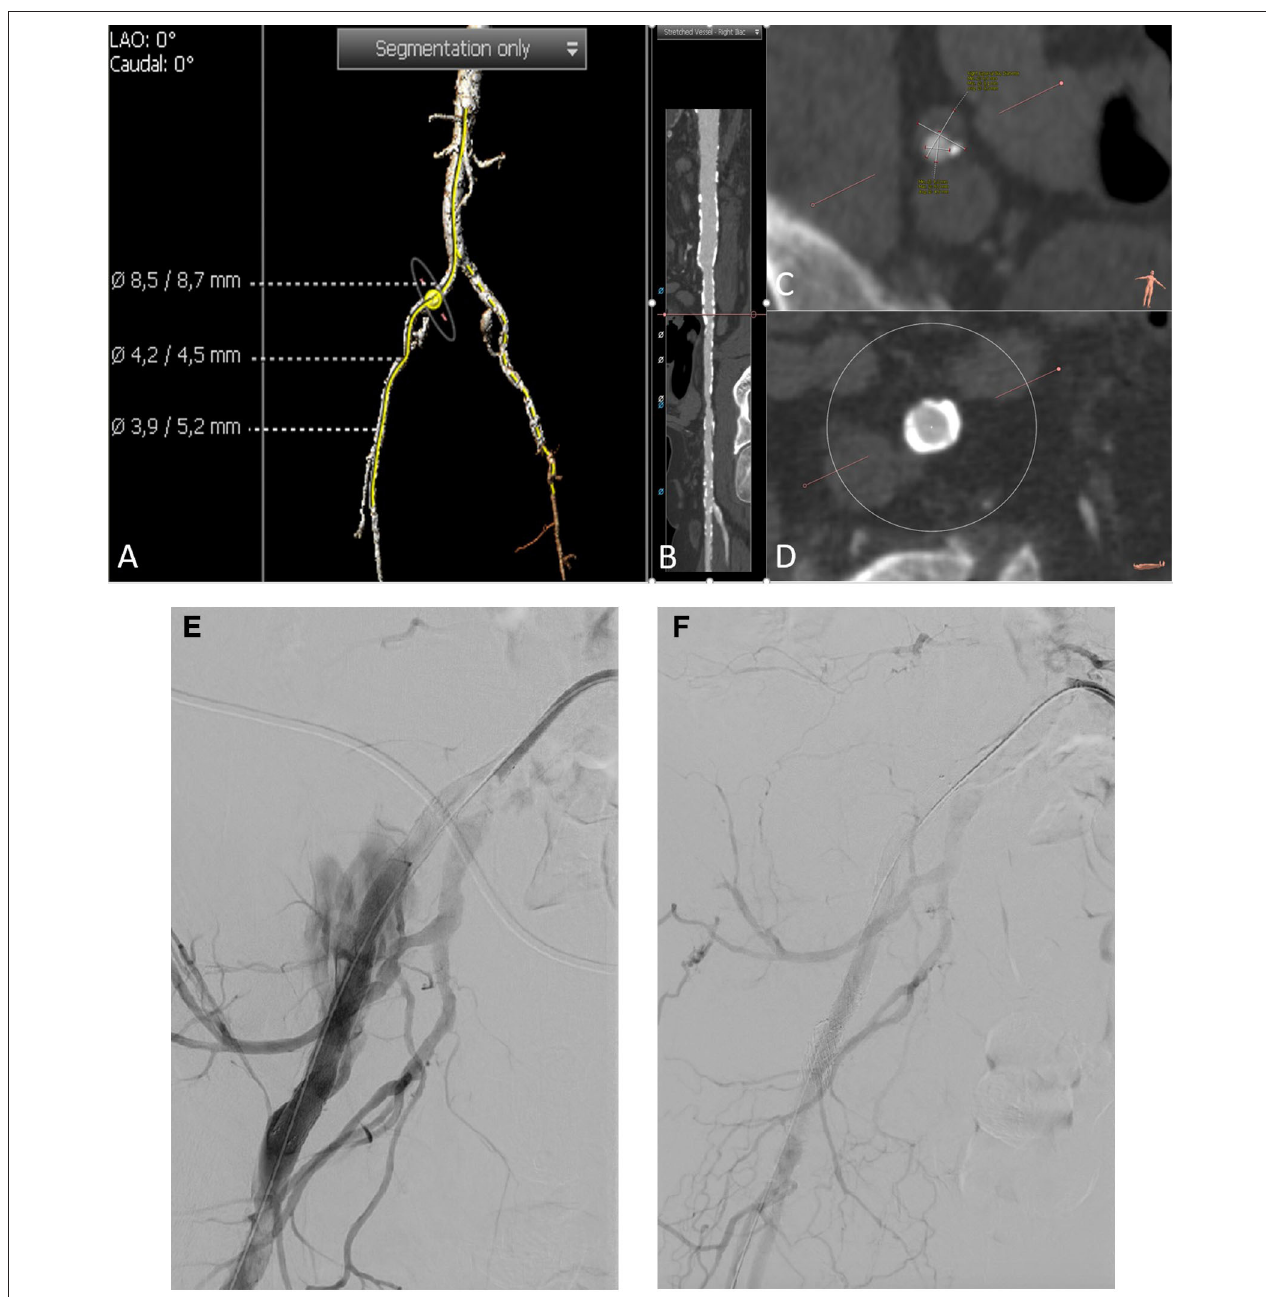
FIGURE 3 | A CT angiography unraveled severely calcified iliofemoral arteries (A–D) . Three-dimensional reconstruction of pelvic arteries with the measurement of common femoral artery diameter, minimal external iliac diameter, and common femoral arterial diameter (from up to down) (A) . A stretched vessel analysis of the right pelvic axis shows severe calcification of the vessel (B) . Minimal diameter of the right external iliac artery is 4.2mm (C) . Right common iliac artery with circular calcification (D) . After initial discussion of a pre-TAVI vessel preparation with by lithoplasty according to the CT angiography, we decided to go on without any peripheral intervention before TAVI. The balloon valvuloplasty of the aortic valve was performed without any complications. Afterward, we were not able to pass the new valve (CoreValve TM , Medtronic, Ireland) through the iliac artery on the right side. Thus, we decided to upsize the sheath to 18F (Sentrant TM , Medtronic), again we were not able to pass the iliac arteries. Another angiography showed a perforation of the right external iliac artery (E) . We immediately blocked the bleeding site with an 8.0mm × 80mm balloon (Charger, Boston Scientific, MS, USA). We now implanted an 8.0mm × 100mm as well as a 8F compatible 11mm × 39mm balloon expandable covered stent prothesis (Gore ® Viabahn ® VBX, Gore) which finally fixed the perforation (F) .